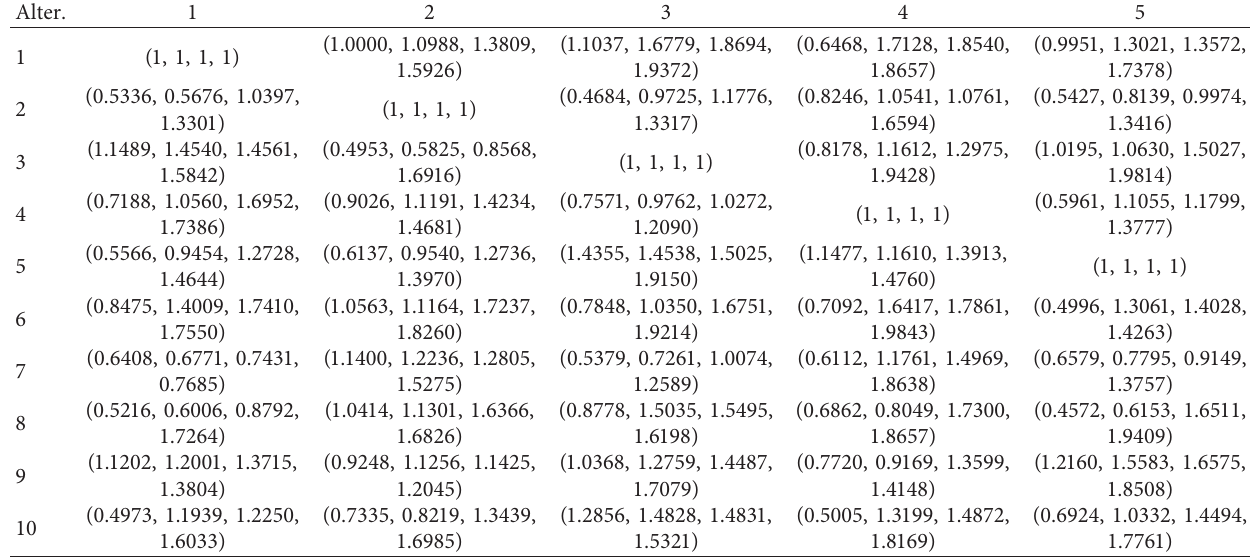
(part 1: columns 1–5). LRL